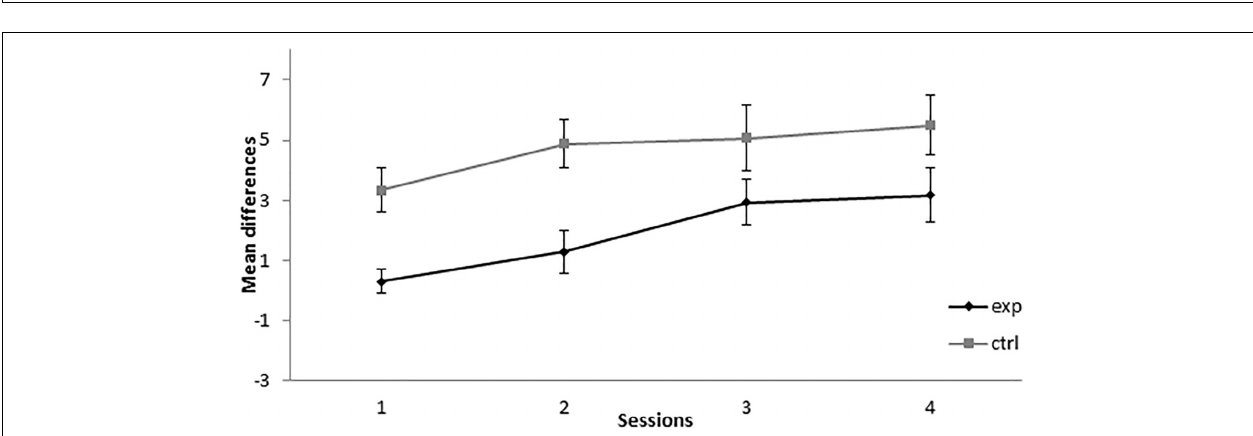
FIGURE 3 | Conditioning phase in Experiment 2. PreX-X differences ( ± SEM), averaged for the two X – presentations per session in conditioning, are displayed. The black line represents the group that was trained with eight A+, eight AX – , six F – , six F+, and two X – presentations per session in conditioning. The gray line represents the group that was trained with eight A+, eight BX – , six F – , six F+, and two X – presentations per session.